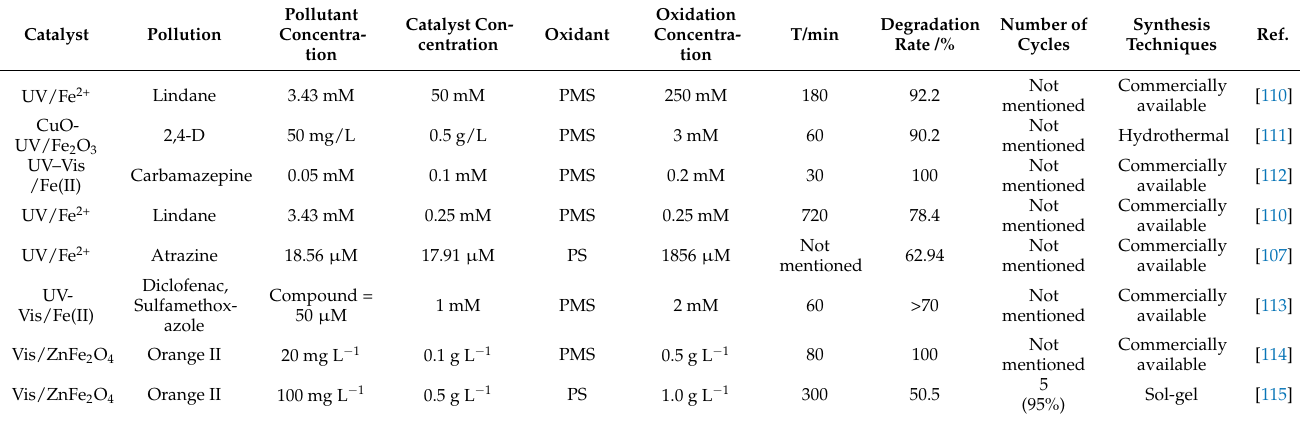
Table 5. Effects of different iron-based catalysts on degradation of different pollutants under ultraviolet lamp irradiation [107,110–115]. Catalyst